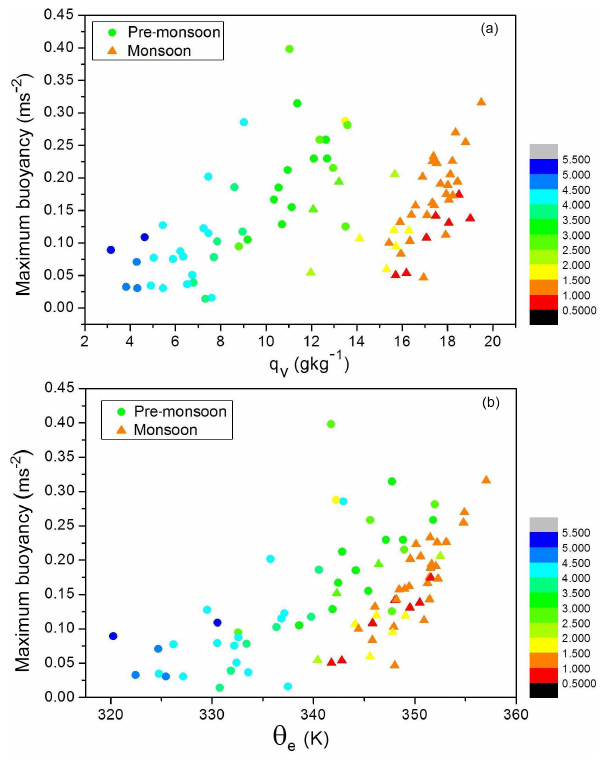
Figure 6. Variation of the maximum quasi-adiabatic buoyancy as a function of (a) surface water mixing ratio and (b) surface equivalent potential temperature. Triangular/circular symbols are for monsoon/pre-monsoon soundings, with the colour depicting the cloud base height. Pre-monsoon cases are grouped as in Figs. 4 and 5.